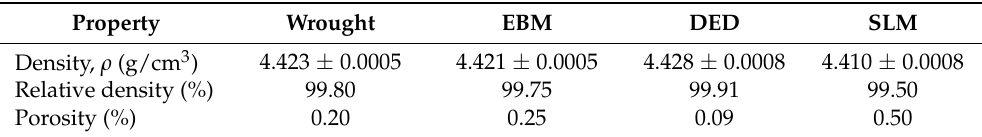
Table 2. The analyzed density and the porosity of the commercial Ti6Al4V rod sample and in the three Ti6Al4V AM samples. Property Wrought EBM DED SLM Density, ρ (g/cm 3 ) Porosity (%)